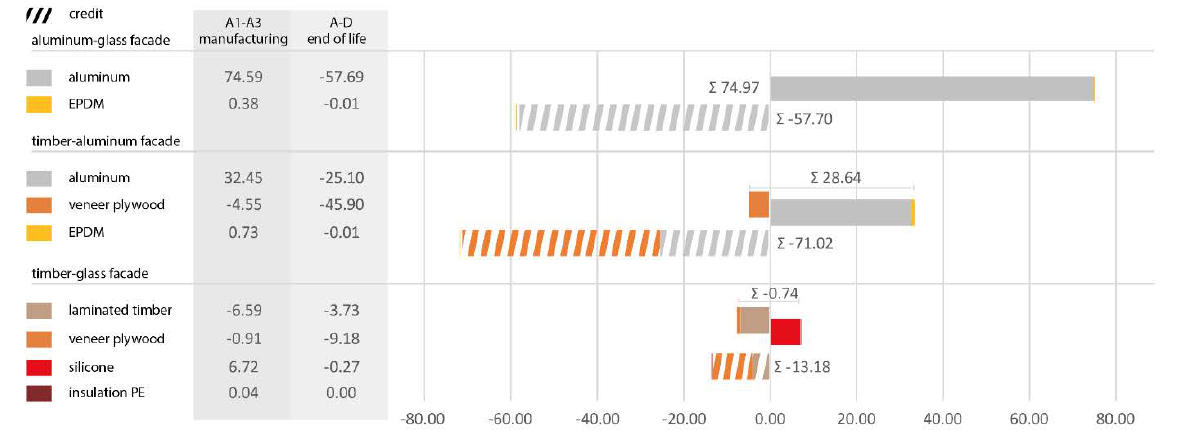
Fig. 8 Primary energy consumption and global warming potential of the three examined facades (as depicted in Fig. 7) (Fadai & Stephan, Ressourceneffiziente Planung großflächiger Holz-Glas-Fassaden, Ökologische und energetische Bewertung (Glasbau 2020),